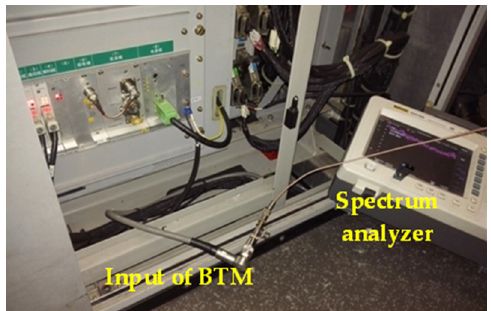
Figure 17. Field tests for the critical condition T of BTM system.